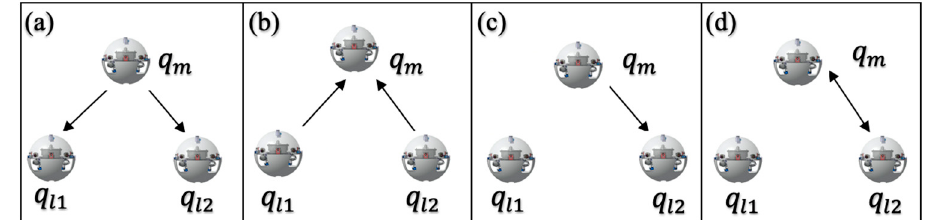
Figure 10. Contract net based on the task allocation. ( a ) Task transfer; ( b ) Bidding; ( c ) Authorization; ( d ) Confirmation.